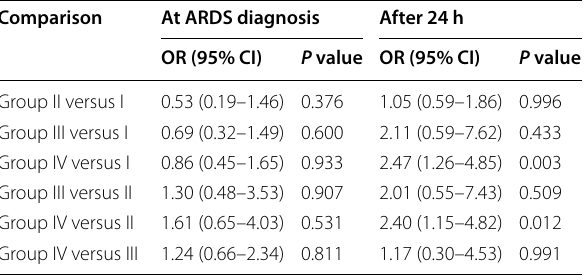
ARDS acute respiratory distress syndrome, OR odd ratio, CI confidence interval